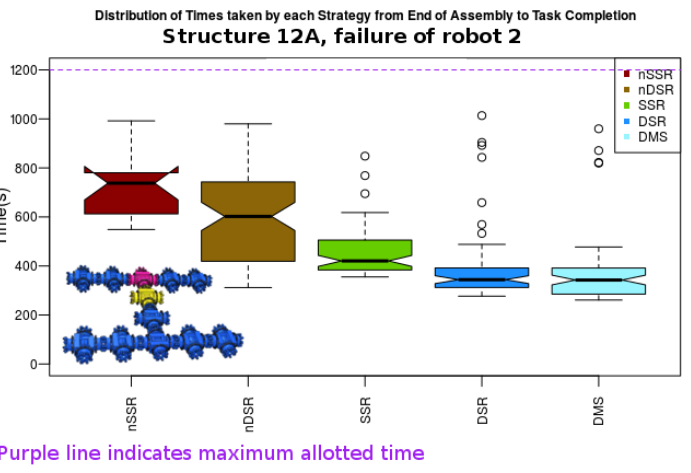
Figure 12. A boxplot showing the task completion times when Robot 2 fails in structure 12A. Robot 2 has a single large substructure of 6 modules attached below port 4. DSR out-competes SSR, but has quite a few outliers where substructures became lost and struggled to find the Replacement Module’s recruitment cone. Dynamic Master Switching allows the larger part of the structure to remain and has the row of 5 robots, containing the original master, act as the Removal substructure. This alteration has negligible effect on task-completion times; the challenge here still remains that of navigating a large substructure back in to place. The structure is shown for reference with the master robot marked in pink and the failed robot in